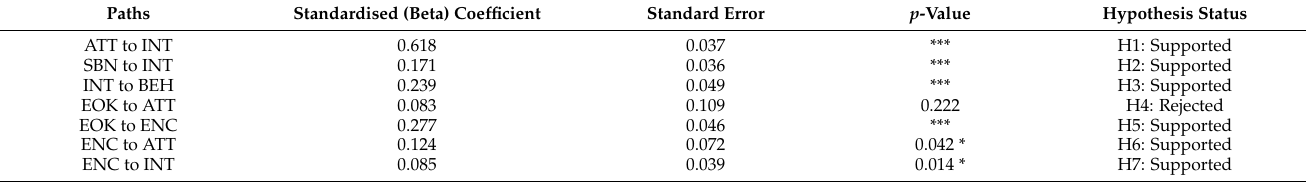
Table 8. Path analysis of the proposed TRA-extended model and its status.